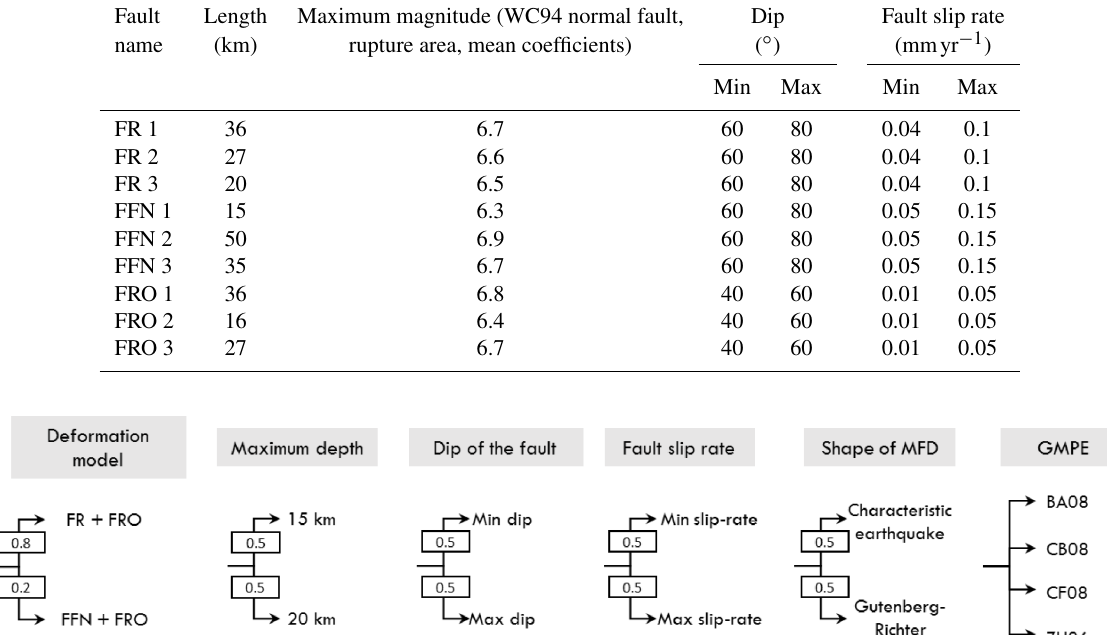
Figure 1. Logic tree explored in this study: the weight attributed to each hypothesis is shown by the number in the boxes. GMPEs are explored separately (no weight